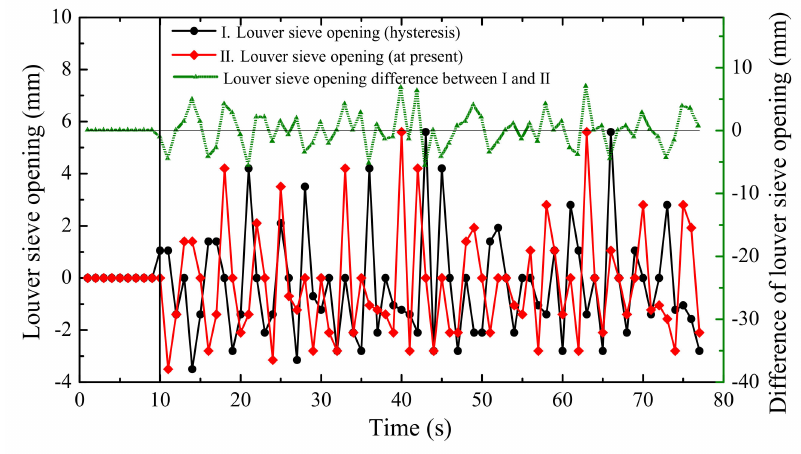
Figure 10. The impact on cleaning loss caused by time